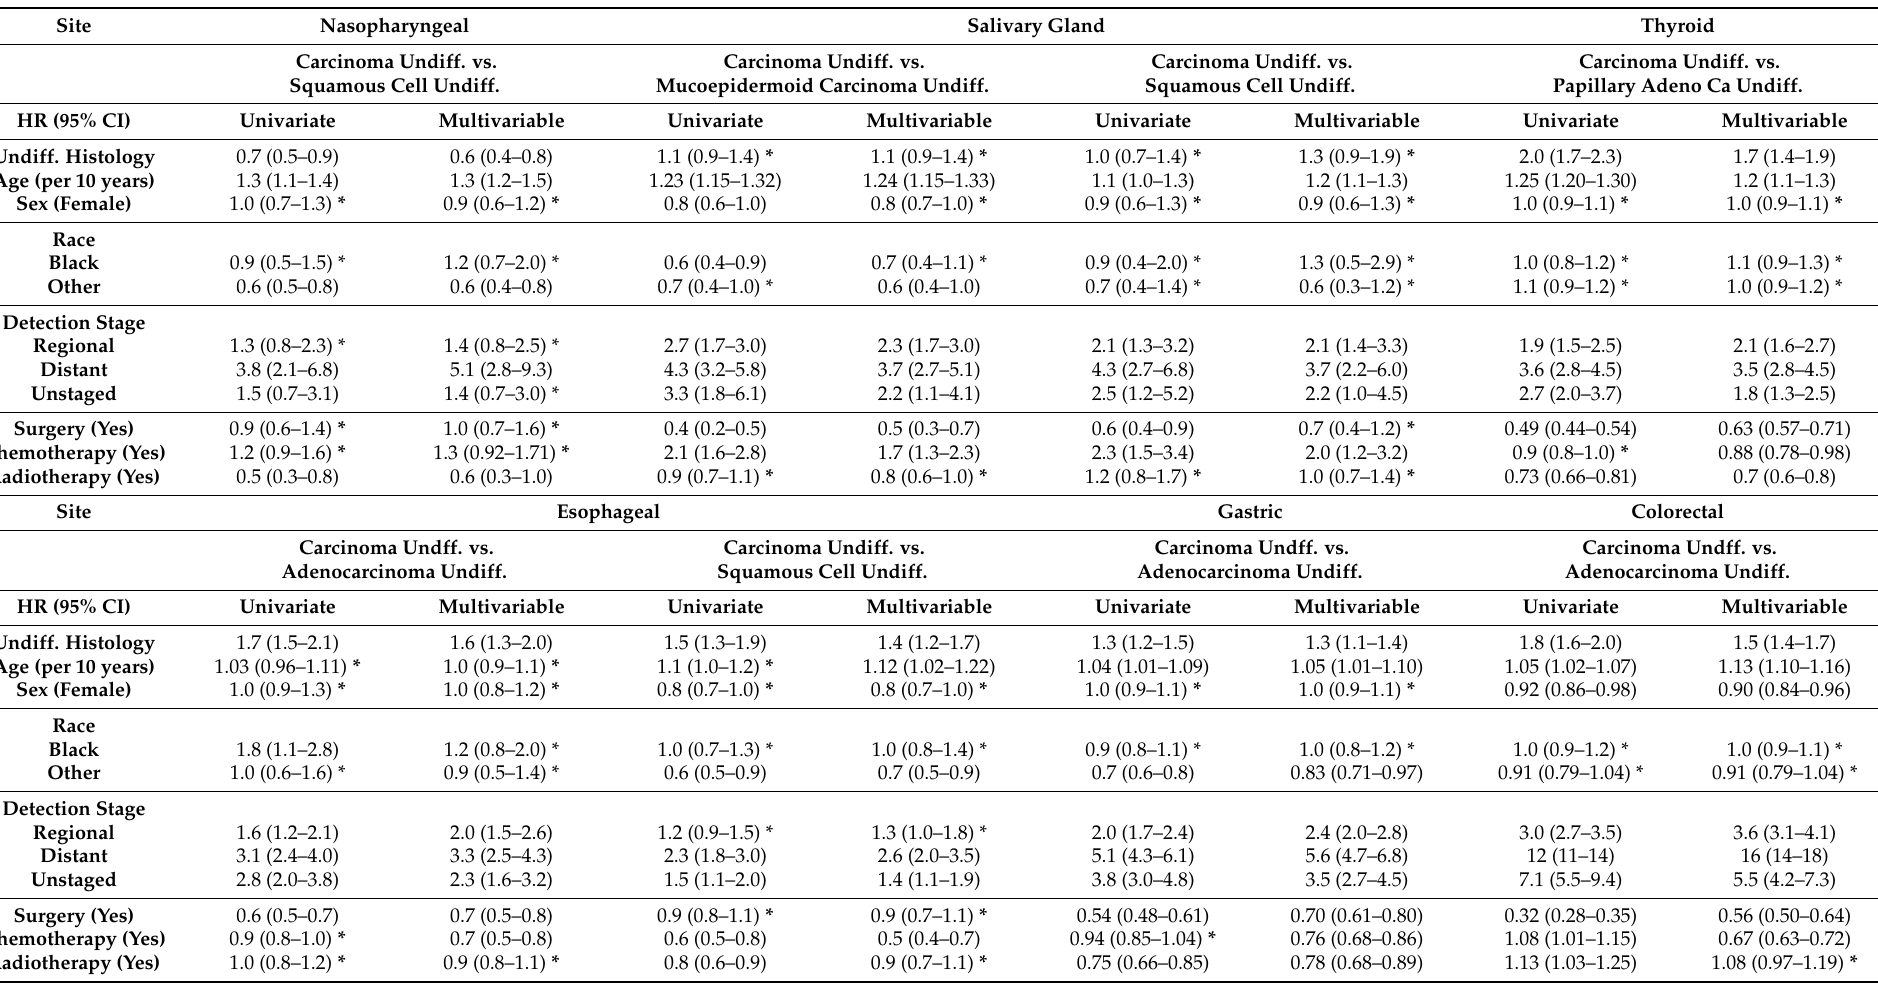
Table 2. Derived univariate and multivariable Cox-proportional hazard ratios (HR) of mortality for included sites. Site Nasopharyngeal Salivary Gland Thyroid Carcinoma Undiff. vs. Carcinoma Undiff. vs. Carcinoma Undiff. vs. Carcinoma Undiff. vs. Squamous Cell Undiff. Mucoepidermoid Carcinoma Undiff. Squamous Cell Undiff. Papillary Adeno Ca Undiff. Univariate Multivariable Univariate Multivariable